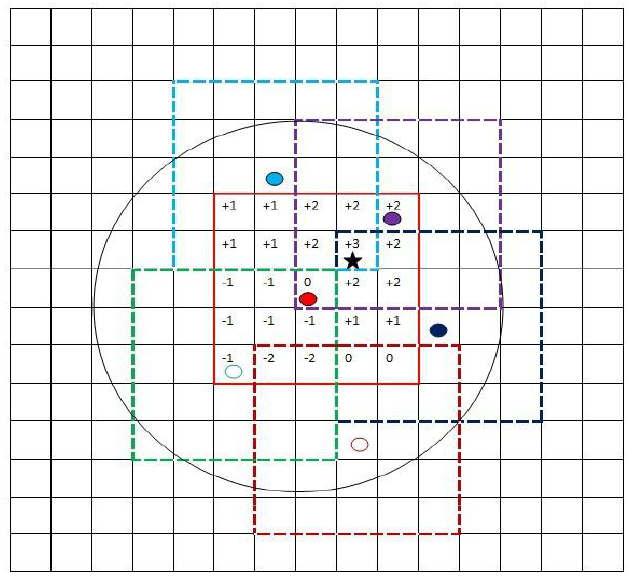
Figure 3. Likelihood matrix L calculated by the